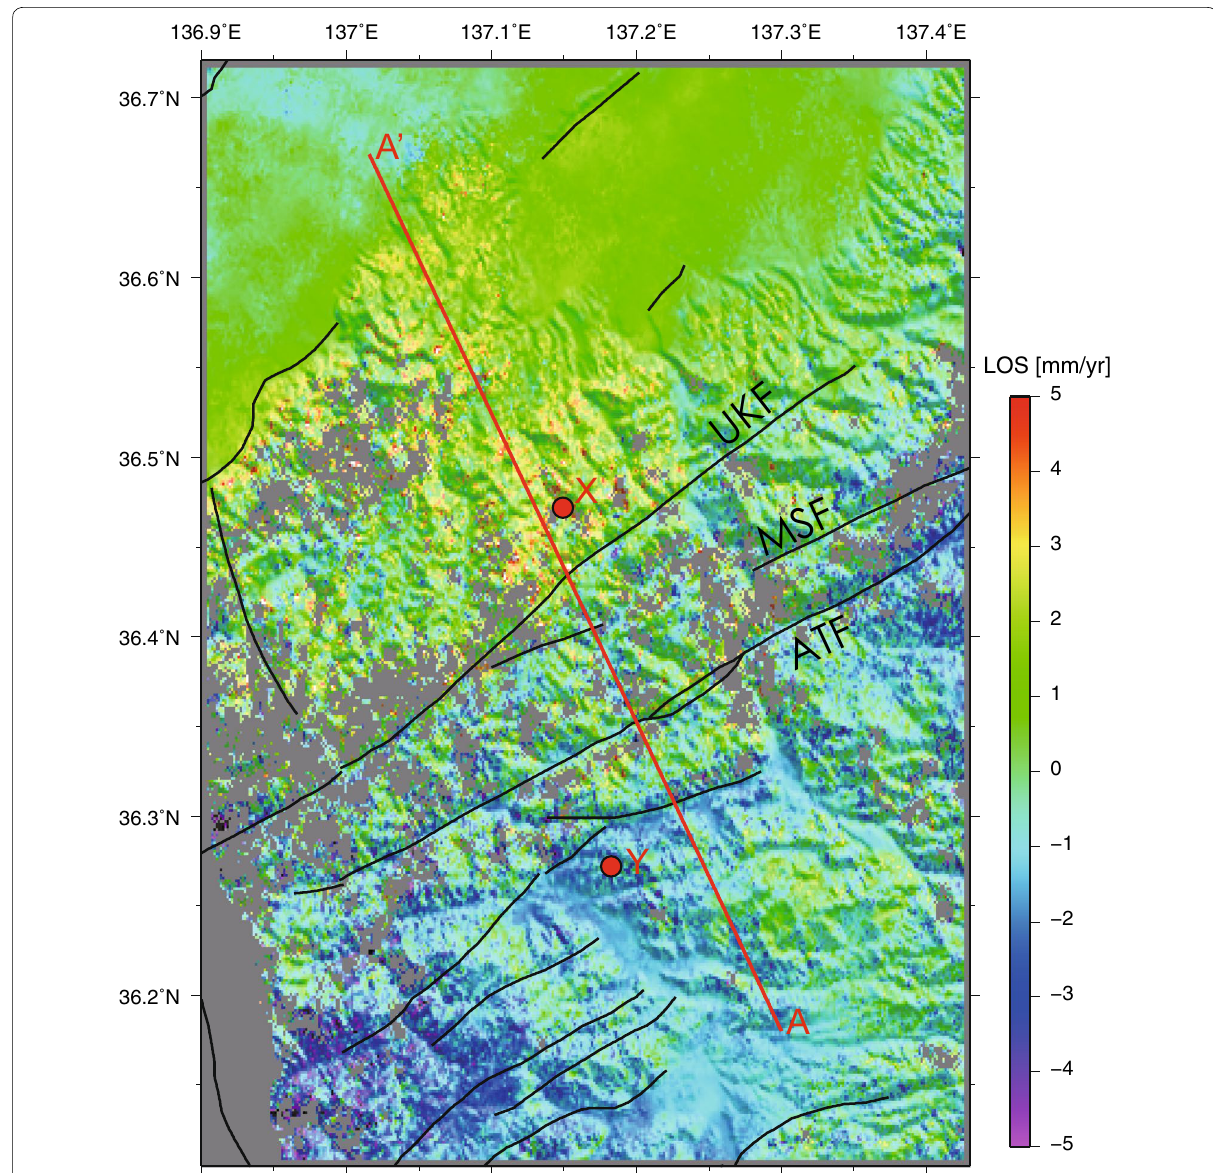
Fig. 7 Mean velocity field calculated by the time-series analysis using corrected interferograms. The area of this figure is indicated in Fig. 3. Note that the color scale ranges from 5 to 5 mm/yr, much smaller than Fig. 3. Red line (AA’) shows location of the profile in Fig. 8. Two red circles (X and − Y) indicate the sampling points of cumulative displacements in Fig. 10. Black lines indicate the active faults. UKF: Ushikubi fault. MSF: Mozumi–Suke- nobu fault. ATF: Atotsugawa fault. Spatial gradient in the LOS velocities across UKF is larger than that across ATF and